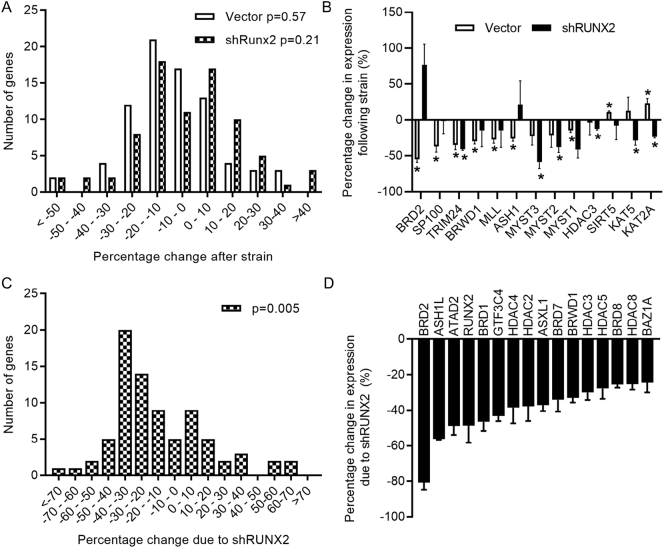
BRD2 is a strain and RUNX2 responsive gene. shRUNX2 and vector control cells were subjected to strain and harvested 8 h later for quantification of candidate epigenetic regulators using custom RT-qPCR panels. Distribution of differences in the expression of candidate epigenetic regulators in vector control or shRUNX2 (A) and shRUNX2 cells versus vector control cells (B). P values indicated are Shapiro-Wilk's tests for normality, indicating that RUNX2 knockdown, but not strain, skewed the distribution of percentage changes in epigenetic candidate gene expression towards down-regulation (A and B). Epigenetic regulators significantly modulated by strain (C). When genes were significantly regulated in one but not the other cell type (control or shRUNX2), the percentage changes are shown but without asterisks over the non-significant bar (* p < .05, ** p < .001 versus static controls of the same cell type). Epigenetic regulators differentially expressed between shRUNX2 and vector cells (p < .05) (B). Arrows indicate genes previously reported to be RUNX2 targets in Saos-2 cells. Bars represent the mean ± SEM, n = 3 representing three independent experiments.